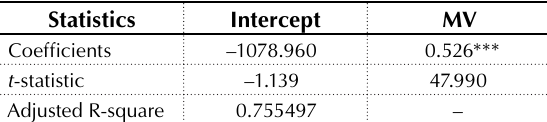
Figure 1. The scatter plot of 2018 MVA and market value (million Table 3. The cross-sectional regression of 2018 MVA and market value